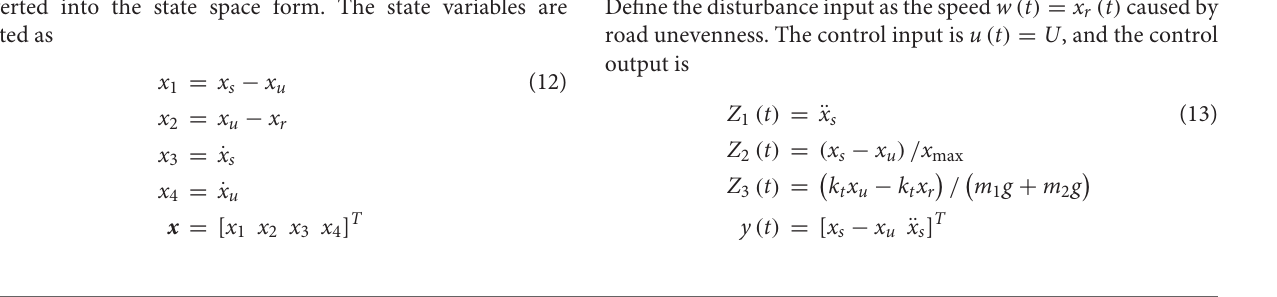
converted into the state space form. The state variables are selected